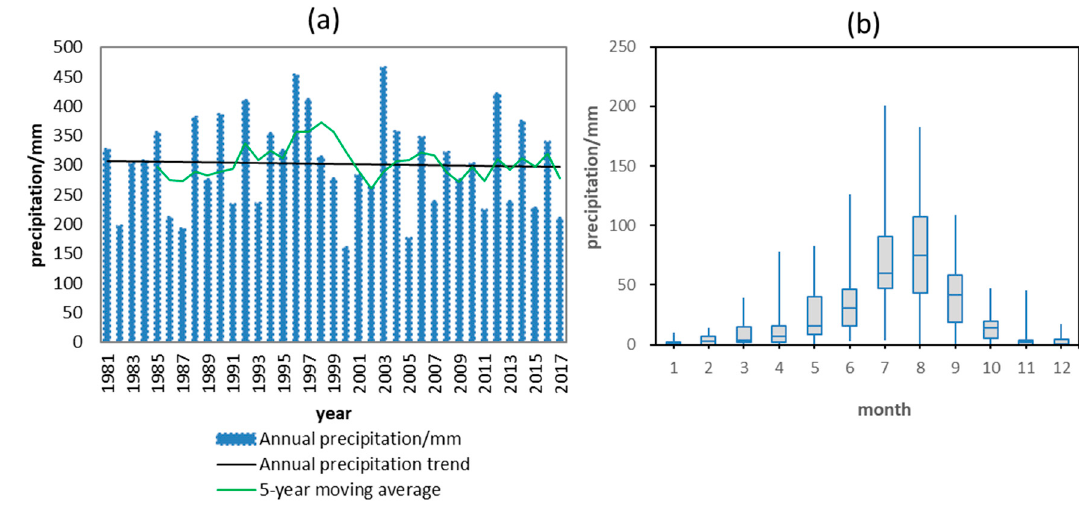
Figure 3. Annual precipitation trend ( a ) and monthly precipitation range ( b ).